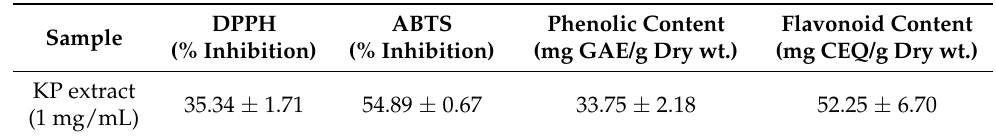
Table 1. Free radical scavenging activity. Total phenolic content and total flavonoid content of KP extract.